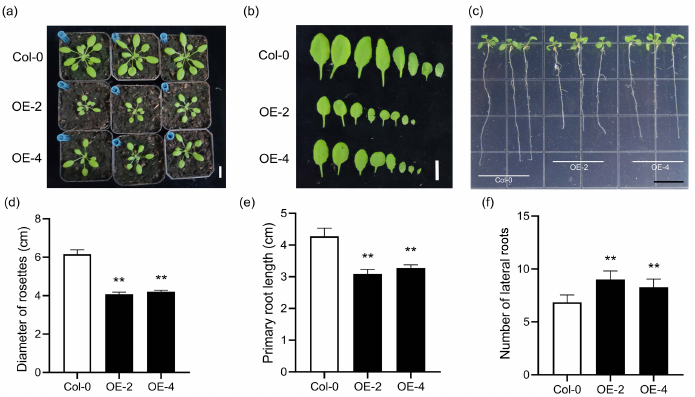
Figure 6. Phenotypes of transgenic Arabidopsis over-expressing SiLBD21 . ( a ) Three-week-old WT and transgenic plants (bar = 2 cm). ( b ) WT and transgenic leaves in ( a ) (bar = 1 cm). ( c ) Root phenotype of 10-day WT and transgenic seedlings (bar = 1 cm). ( d ) Diameter of rosette leaves (n > 15). ( e , f ) The length of primary roots and the number of lateral roots (n > 30). Error bars represent standard deviations. Significant differences are indicated: ‘**’, p ≤ 0.01 (Student’s t -test).